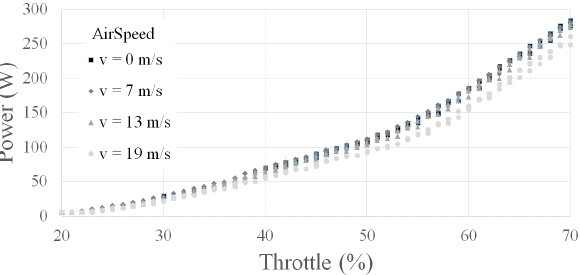
Figure 7. Wind tunnel data of motor electric power at variable throttle